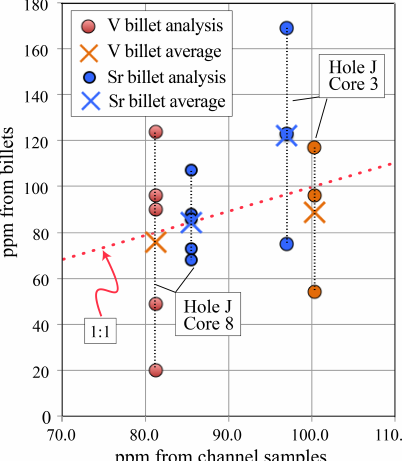
Figure 11. A comparison of the concentrations of Sr and V in chan- nel samples from Cores 3 and 8 in Hole J with the analyses of bil- lets analyzed aboard the JR from the same cores. The average con- centrations of Sr and V in five billets from Core 8 approaches the concentrations in the channel sample more closely than does the average of the concentrations in three billets from Core